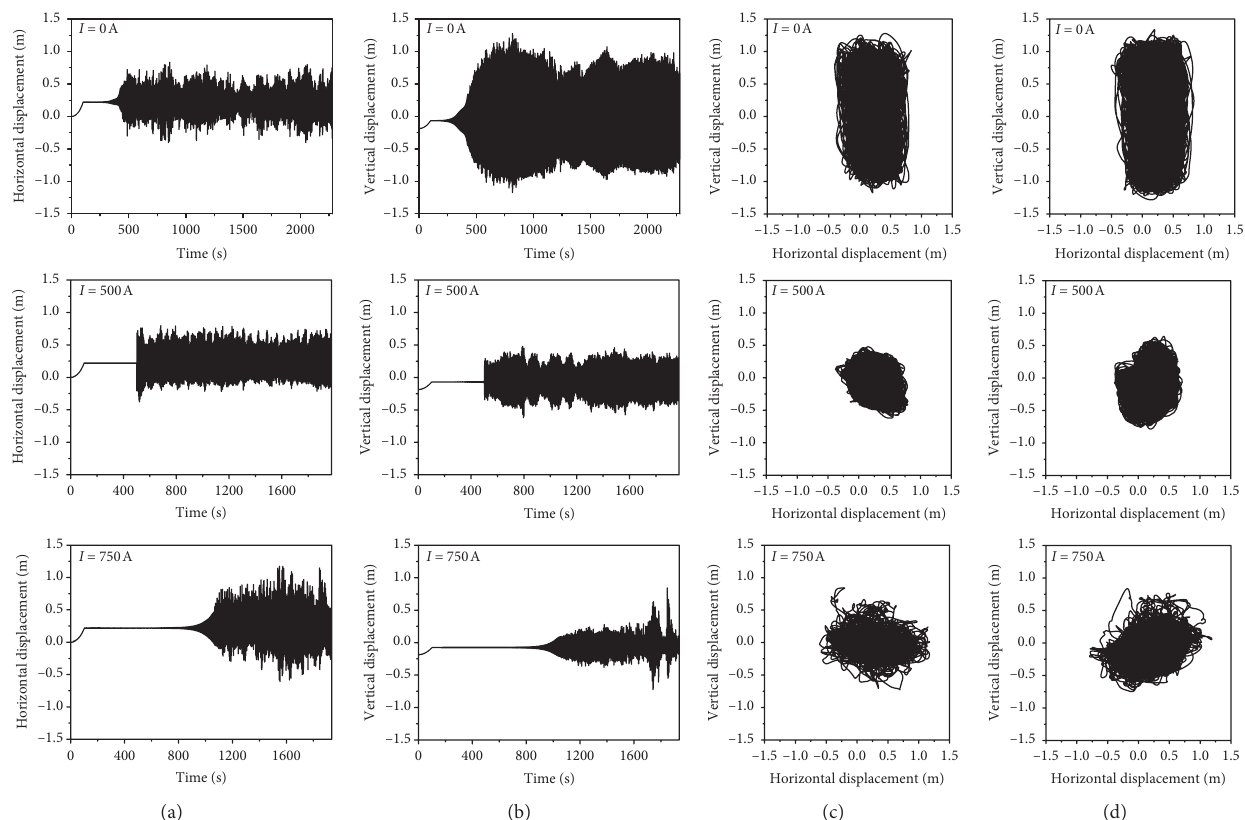
Figure 10: Time histories of displacement on subconductor 1 and motion traces of two subconductors at a subspan 3 midpoint under different currents ( α � 30 ° ): (a) horizontal displacement of subconductor 1, (b) vertical displacement of subconductor 1, (c) motion traces of subconductor 1, and (d) motion traces of subconductor 2. Table 4: Oscillation RMS amplitudes at each subspan midpoint of two subconductors. ( α � 30 ° ). Horizontal displacement (m) Vertical displacement Current intensity (A) Subspan